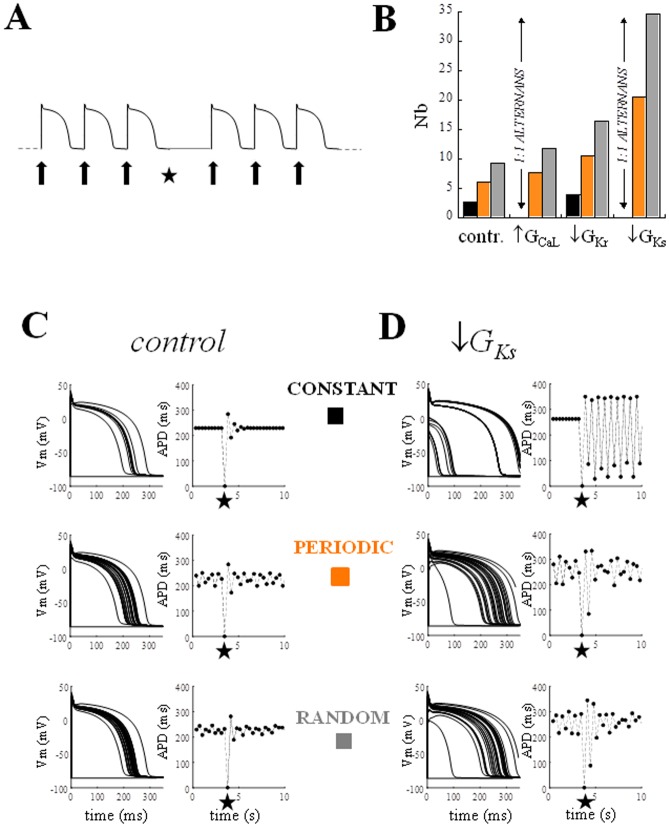
Variable pacing and stability after a missing beat.AP trains under different pacing conditions were perturbed by turning off the current stimulus (star) for one beat (A). The difference between APDs following the missing beat and those of the unperturbed sequence were measured and the number of beats (Nb) required for such a difference to reach a value < 2 ms measured. (B) The histogram shows Nb measured during constant (black), periodic (orange), and random (grey) pacing (CL* = 350 ms, clv = 35 ms, ω = 2.4) in control conditions and for each AP prolonging treatment (see Fig 7). In the case of an increase in GCaL and a decrease in GKs the missing beat triggered stable APD alternans. A transient alternans between short APD values was also present under a decrease in GKs, but progressively disappeared within 30 beats. (C) Example of data generating histogram in B. Consecutive AP waveforms (left-hand column) and APD time course (on the right) are shown for 10 s simulations in control conditions under constant, periodic, and random pacing and with a missing beat (star) in each sequence. (D) Same for AP prolonged by decrease in GKs.